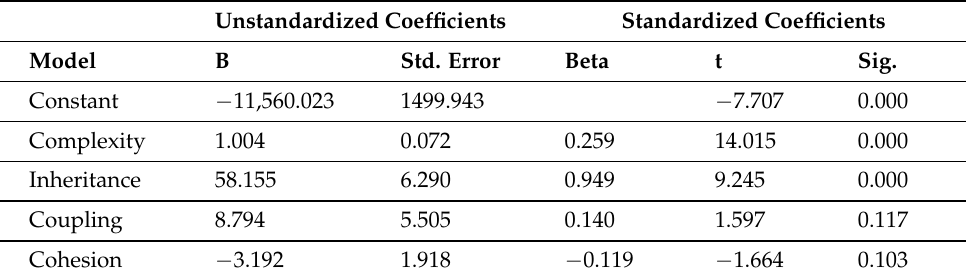
Table 5. Multicollinearity